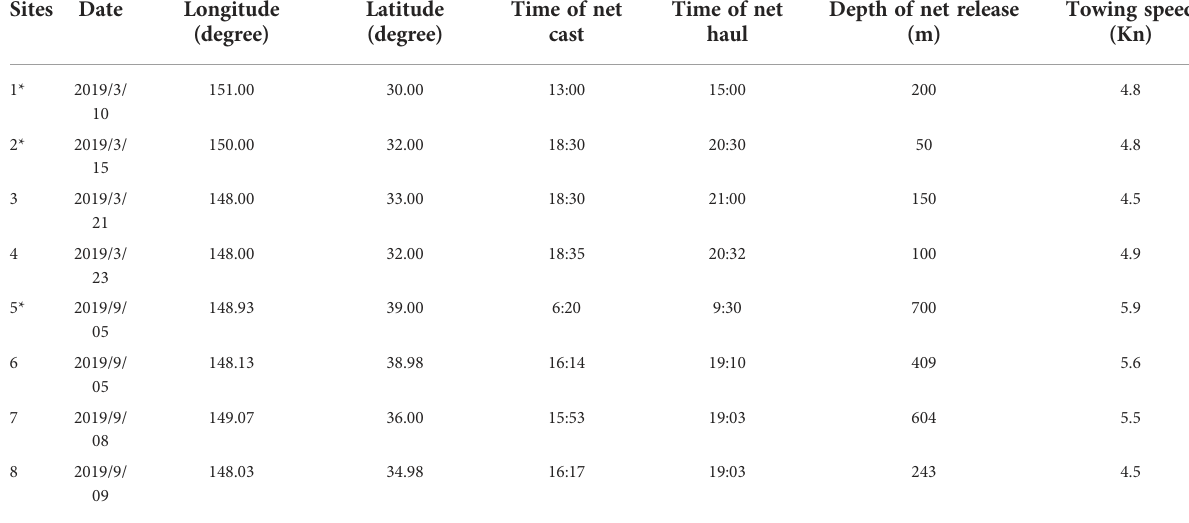
TABLE 2 Trawling sampling site information.